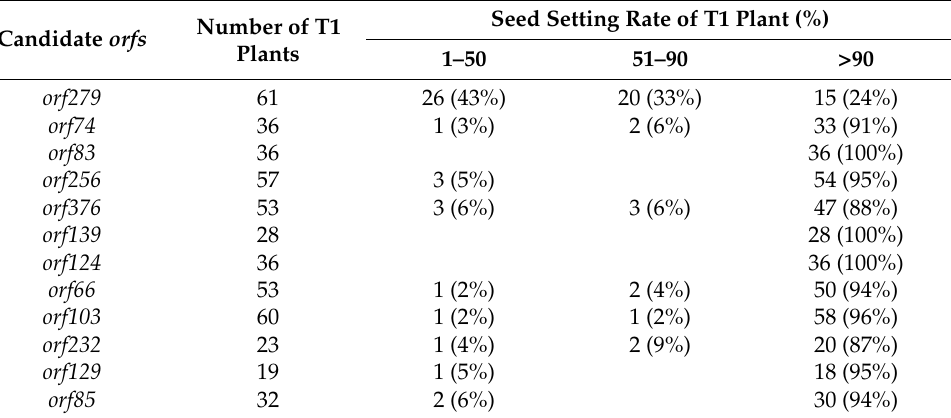
Table 7. Phenotypic study of transgenic Arabidopsis thaliana containing 105 bp mitochondrial signal peptide of Rf1b .